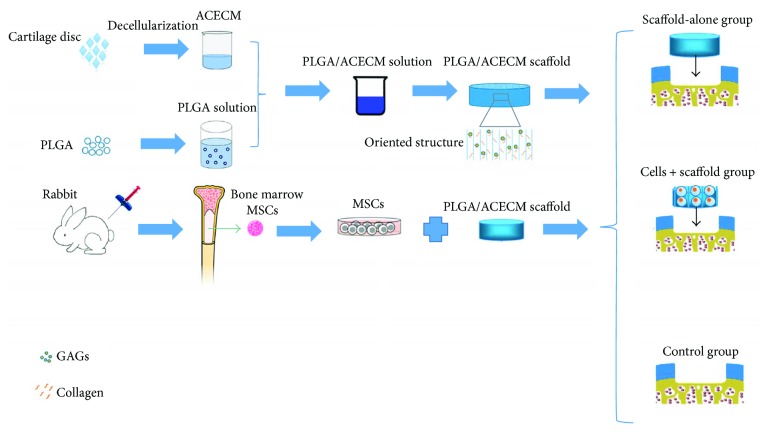
Schematic illustration of the experimental design. Autologous bone marrow-derived MSCs were loaded into oriented PLGA/ACECM composite scaffolds and implanted to regenerate cartilage defects in a rabbit model. The study involved three groups: a cell-loaded scaffold group, a scaffold-alone group, and an untreated (control) group.